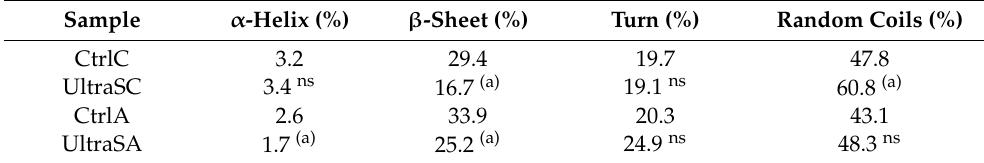
Table 2. The secondary structures in almond and coconut protein assessed by CD